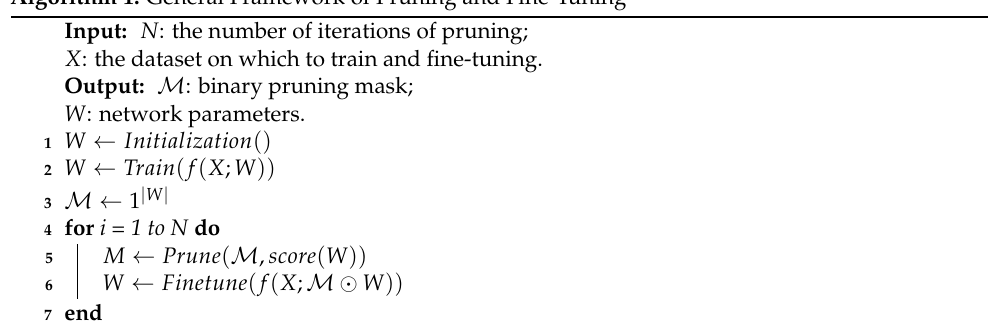
Algorithm 1: General Framework of Pruning and